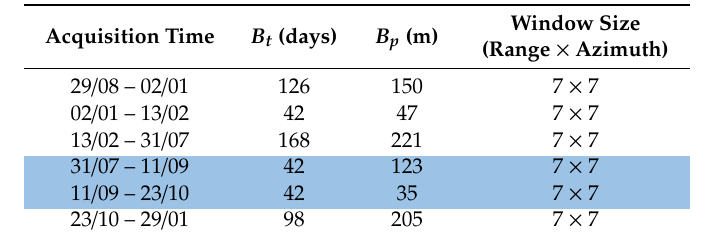
Table 4. ALOS-2 / PALSAR-2 coherence data used for the Joso case study (flood acquisition is marked in blue